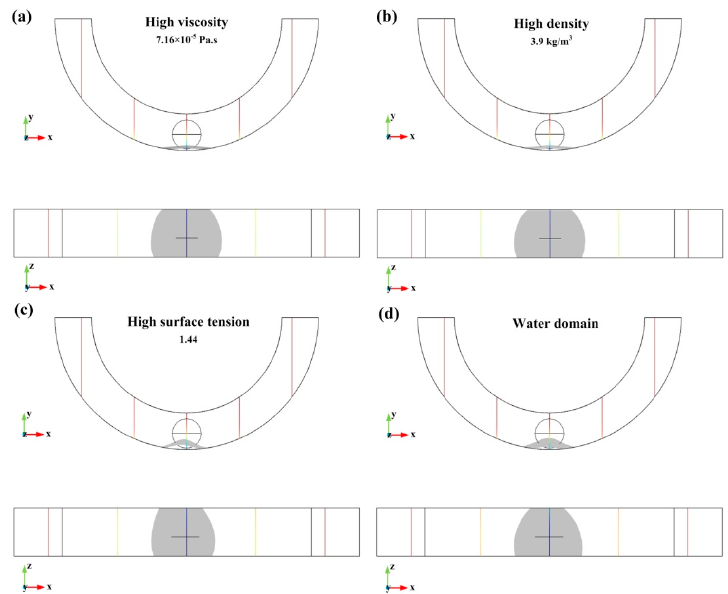
Figure 9. The simulation results of the droplet deformation in different material properties; ( a )–( d ) are the deformation of acceleration in high viscosity, high density, high surface tension, and water domain, respectively.